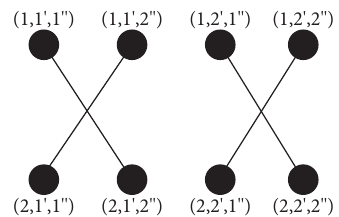
Figure 5: NEPS P